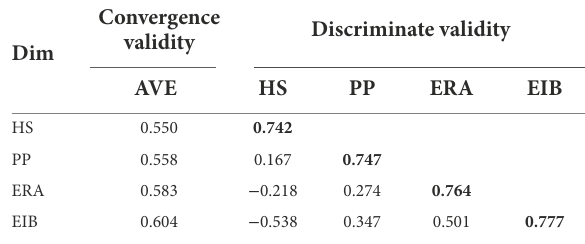
TABLE 2 Variables’ correlation coefficient and the square root of AVE. Dim